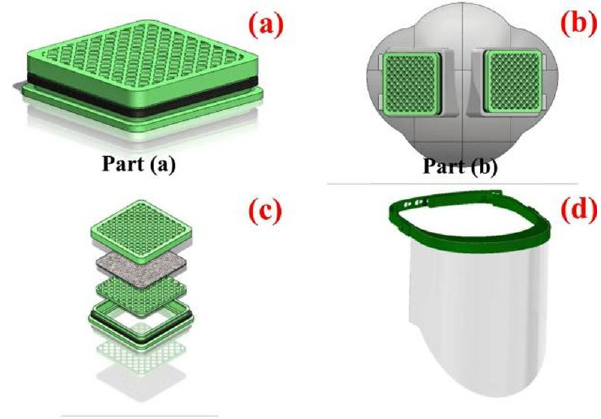
Figure 9. Schematic representation of the design of the nanofibrous respirator face mask. Part ( a ) depicts the respirator filter containing multilayers of CuONPs/GO@PLA and CuONPs/GO@CA nanofibers. Part ( b ) represents the fixed part of the face mask. The assembly of the multilayers con ‐ sisting of nanofibers into a respirator filter is shown in ( c ). The face shield containing two parts and fabricated via the molding procedure is shown in ( d ). Reprinted with permission from ref. [127] . Huang et al., identified the bacteria viability on common face masks and found that the majority of bacteria (90%) remain alive after 8 h [128]. The authors reported that using laser ‐ induced graphene (LIG) they obtained nearly 100% of bacteria inhibition rate under 0.75 kW/m 2 irradiation for 10 min. Very recently Goswami et al., fabricated the function ‐ alized graphene (fG) filter ‐ based 3D ‐ printed facial protective equipment [129]. The au ‐ thors reported that the fG filter shows 84.00%, 92.61% and 98.20% of bacterial filtration efficiency with 20 μ m, 10 μ m and a melt blown filter, respectively, with lower breathing resistance values as compared to other commercialized masks. They tested an fG ‐ coated mask against SARS ‐ CoV ‐ 2 viral particles, showing a complete arrest of viral transmission at fG ‐ coated layers. Modifying the mask filters with graphene has been of great interest due to its potential use as antibacterial and virucidal properties [130]. Indeed, some com ‐ panies have commercialized face masks in which graphene is coated and/or embedded. As for all the nanomaterial composites, a possible limitation of this type of masks could be the leakage of nanoparticles. In fact, some authors reported that the interaction of gra ‐ phene or GO nanoparticles with viable cells and biochemical can be considered unsuitable and dangerous to the human body [131]. For this reason, a challenge in GO ‐ based medical devices is to achieve a stable immobilization of nanomaterials in the devices. The potential degradation of face masks under extreme working conditions was very recently studied by Torres et al. [130] who carried out tests complementary to the present standard tests to ensure the security of new filters based on composites or nanomaterials. 6. Conclusions Several efforts have been made by the research communities around the globe to con ‐ tain and reduce the impact of COVID ‐ 19. However, the rapid spread of COVID ‐ 19 virus